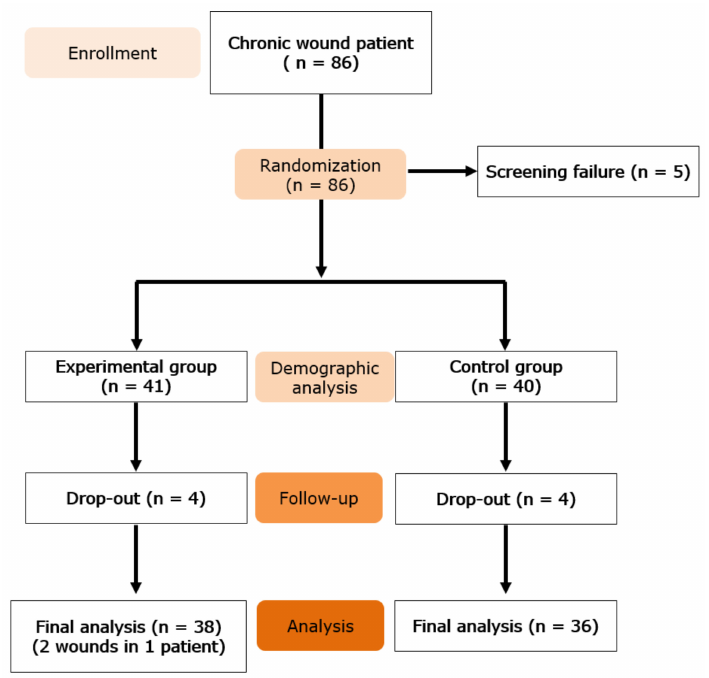
Figure 1. Flow of study enrollment and